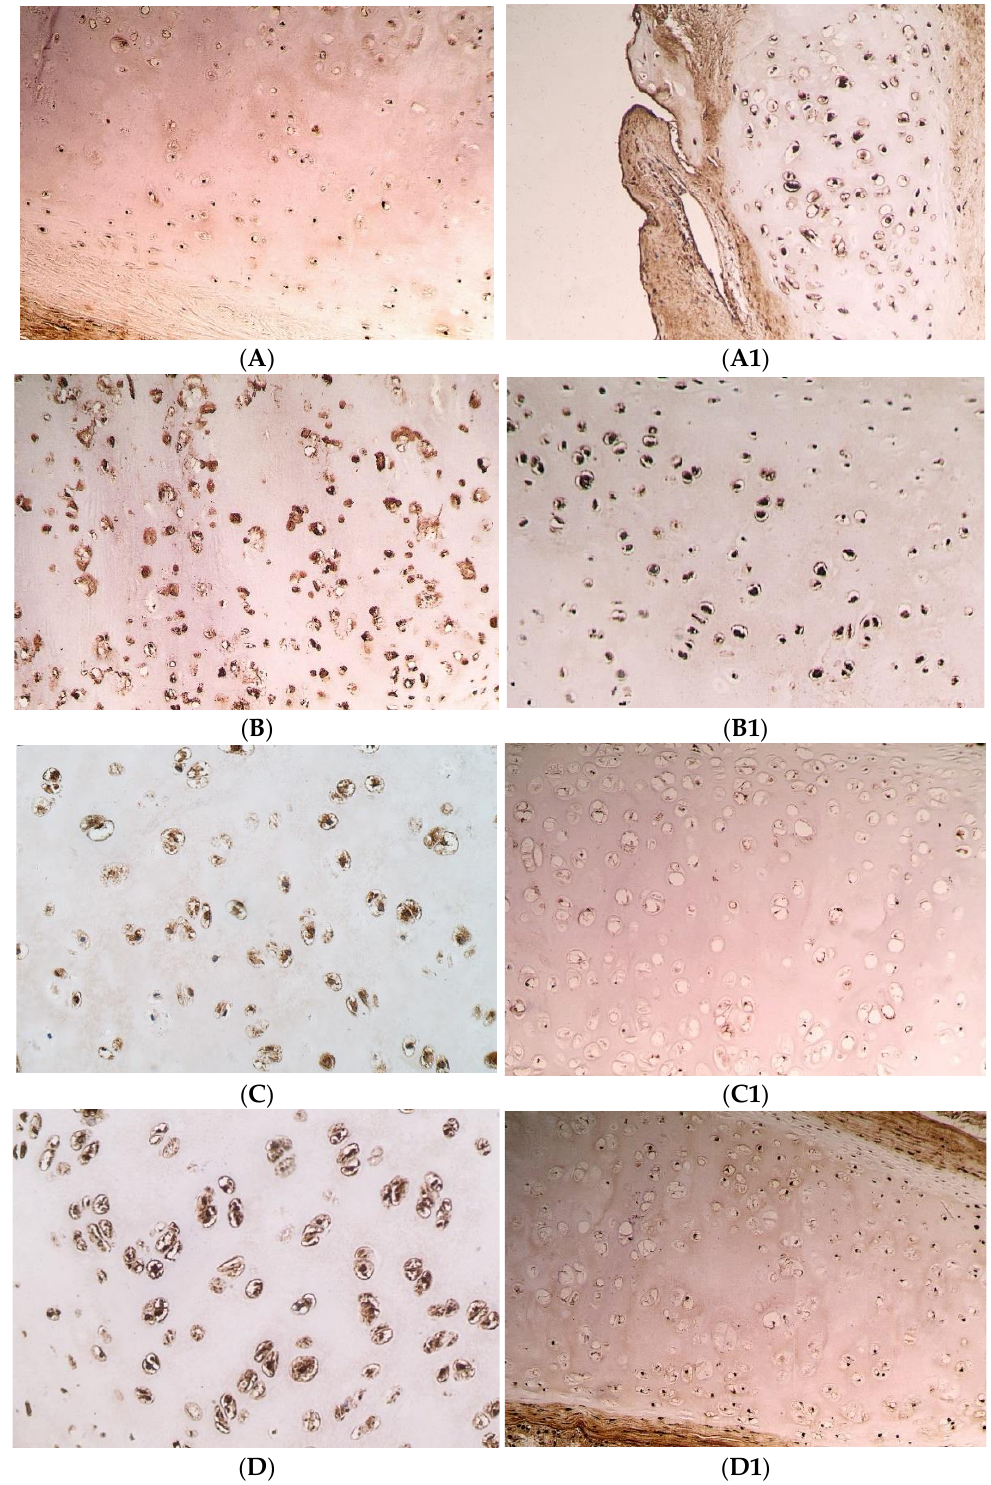
Figure 1. Immunohistochemical microphotographs of relative number of cells of various factors in cartilage in the CLP patients and the control patients. ( A ) +++ MMP-2 positive chondrocytes found in the cartilage of 8 years and 3 months old CLP patient from second-time surgery, IMH, ×200. ( A1 ) ++ MMP-2 positive chondrocytes found in the cartilage of a control patient, IMH, ×100. ( B ) +++ MMP-8 positive chondrocytes found in the cartilage of 7 years and 2 months old CLP patient from second-time surgery, IMH, ×200. ( B1 ) +++/++++ MMP-8 positive chondrocytes found in the cartilage of a control patient, IMH, ×200. ( C ) +++ MMP-9 positive chondrocytes found in the cartilage of 11 years and 6 months old CLP patient from second-time surgery, IMH, ×250. ( C1 ) +/++ MMP-9 positive